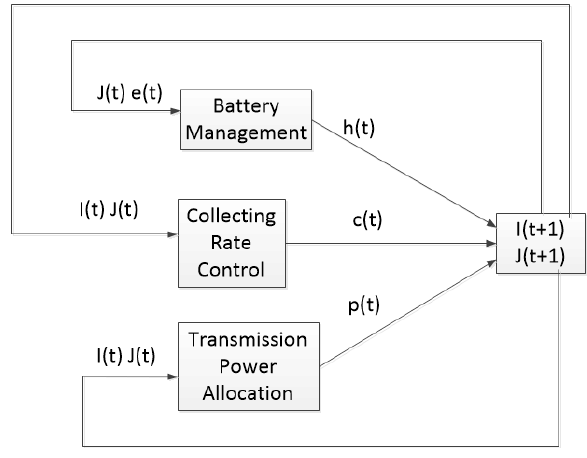
Figure 2. Parameters update diagram of the